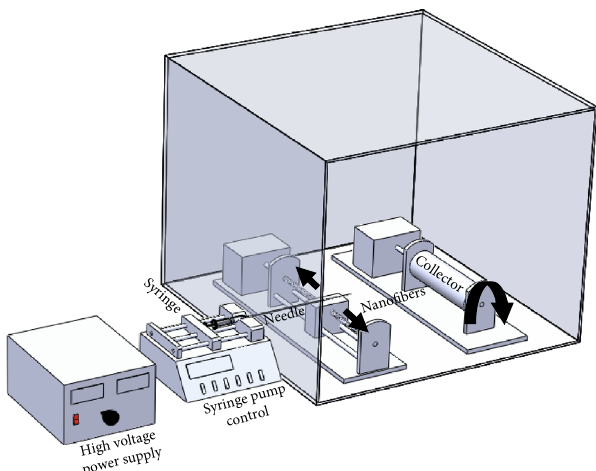
Figure 1: Laboratory-scale electrospinning